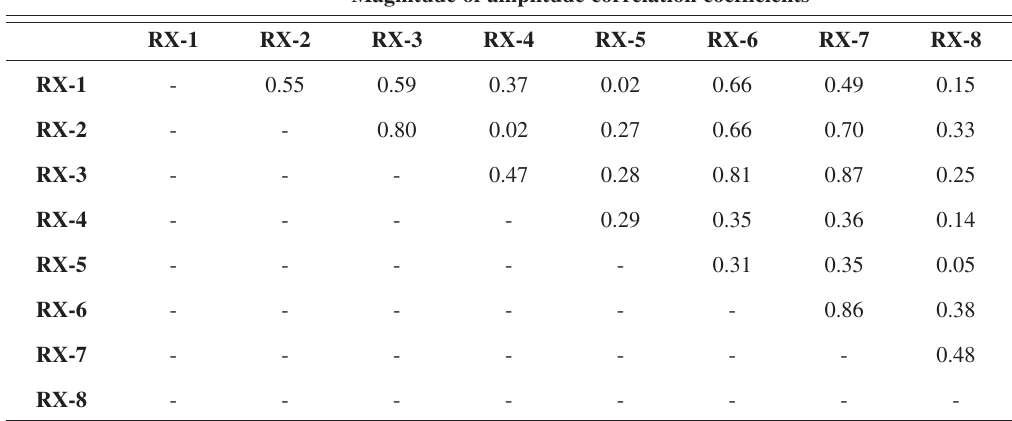
Table II. Amplitude correlation coefficients between the various pairs of receiving antennas that constitute the heterogeneous circular antenna array in Monterfil for TX-1 (N-S crossed wire; 5.795010 MHz) for a period of approximately one minute at 10:20 UT on 3 July